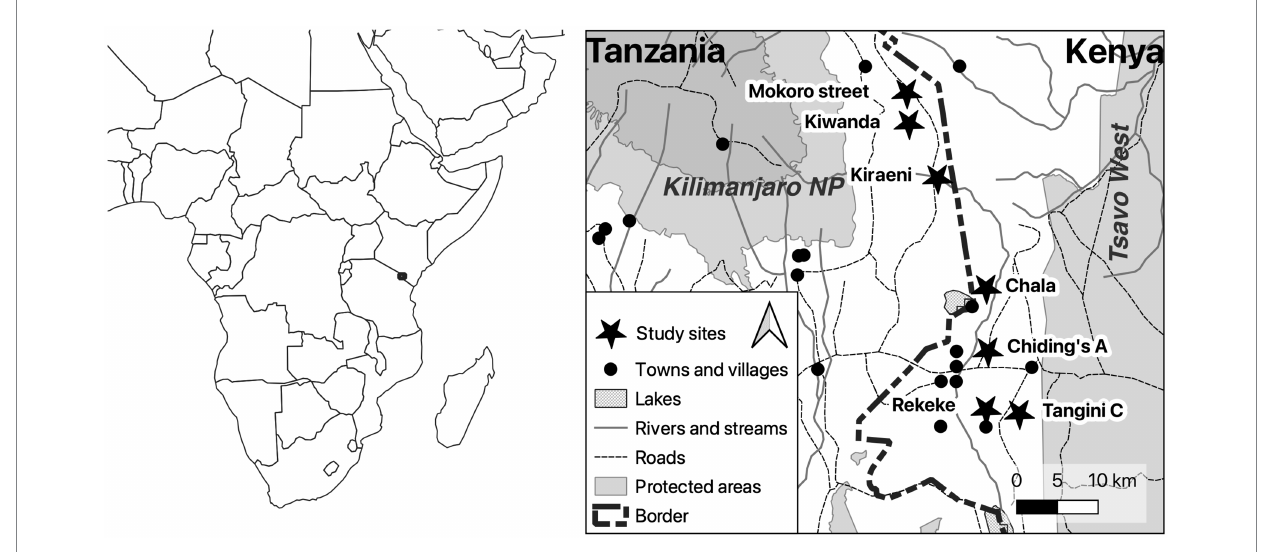
FIGURE 1 Study area on the border between Kenya and Tanzania. The map was created using QGIS version 3.22.9 ‘Białowieża’ (qgis.org) from public domain map datasets from Open Street Map (www.openstreetmap.org), diva-gis (diva-gis.org) and the World Database on Protected Areas WDPA (www.